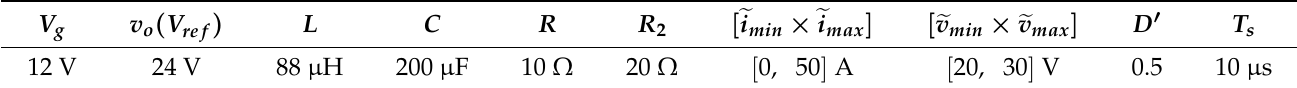
Table 3. Boost converter